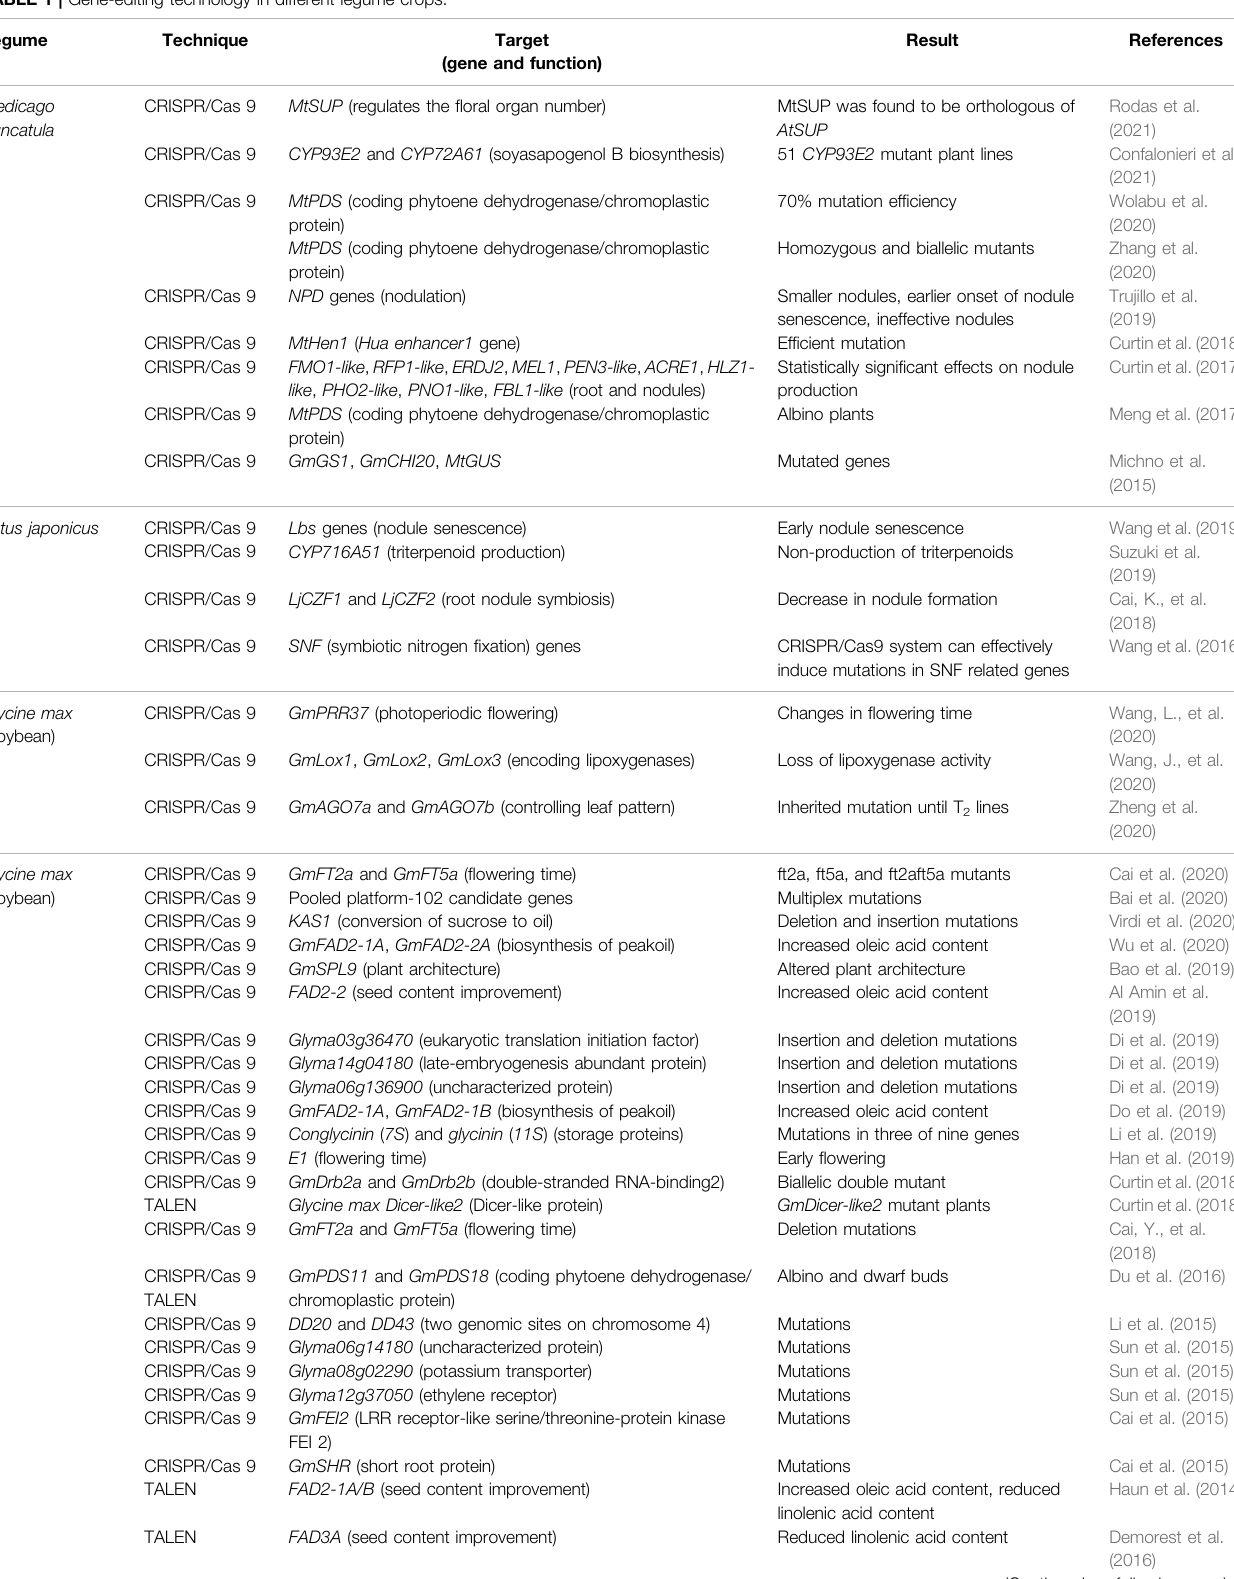
TABLE 1 | Gene-editing technology in different legume crops.